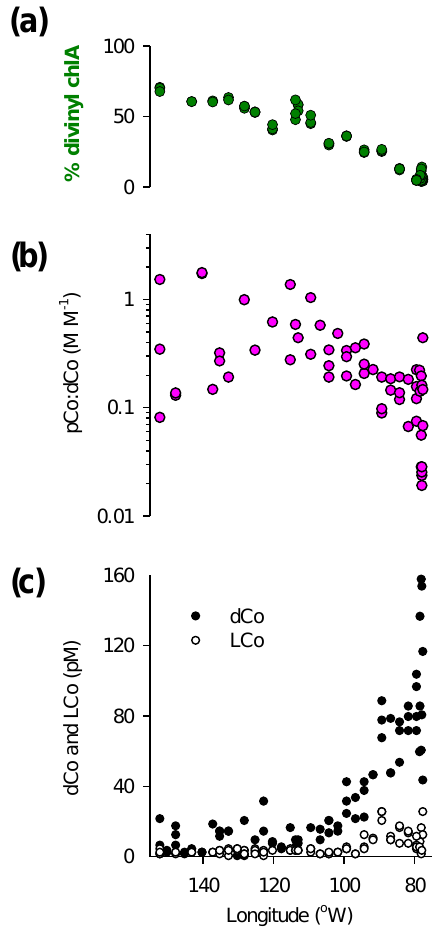
Figure 13. (a) The ratio of divinyl chlorophyll A to total chloro- phyll (green circles), an indication of Prochlorococcus abundance relative to other phytoplankton. (b) The particulate-to-dissolved ra- tio of cobalt (pCo : dCo, in MM − 1 , pink circles) in near-surface samples (0–50m) measured during GP16; a value of 1 indicates equal concentrations in each phase. (c) The near-surface distribu- tion of dissolved cobalt (dCo, black circles) and labile cobalt (LCo, white circles), showing higher concentrations near the Peru margin (<80 ◦ W) and very low dCo to the